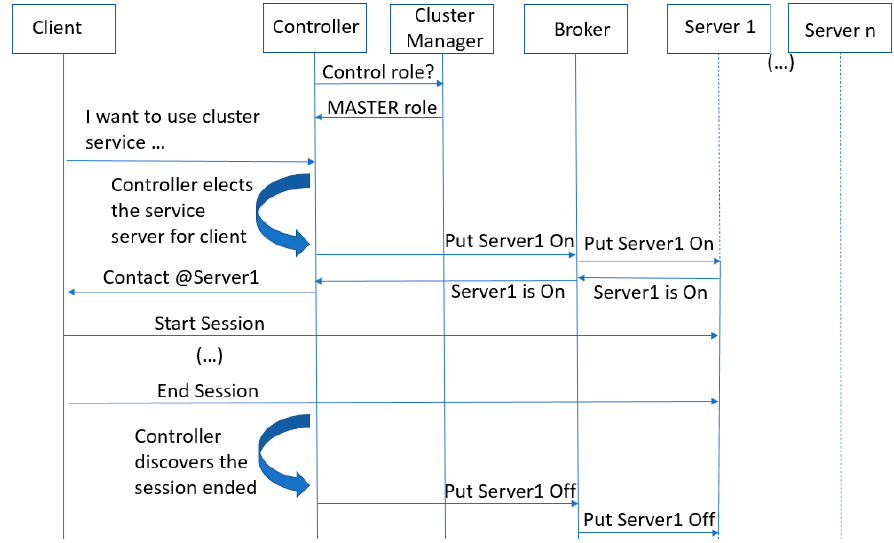
Figure 2. Sequential diagram with the diverse system entities.